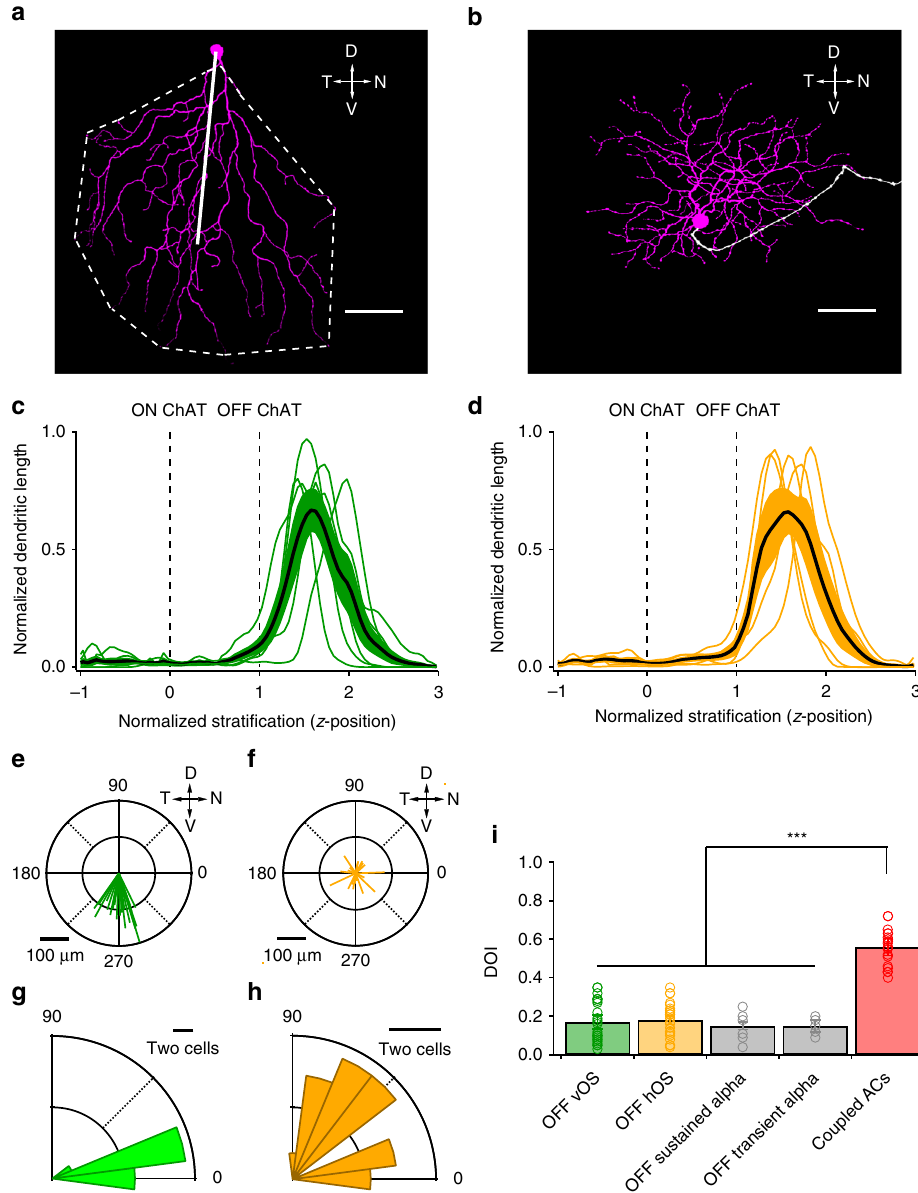
Fig. 2 Morphology of OFF OS RGCs. a , b Dendritic morphologies of vertical OFF OS RGC ( a ) and horizontal OFF OS RGC ( b ). OFF dendrites are represented in magenta and axons are in white. Scale bar = 50 μ m. Dashed line in a shows outline of dendrites. Solid line is the vector from the soma to the center of mass (COM). c , d Z -pro fi les of OFF vOS ( c ) and OFF hOS ( d ) dendritic arbour strati fi cation. Thin green and orange lines indicate pro fi les of individual OFF vOS and OFF hOS cells, respectively. Thick black lines represent mean for OFF vOS ( n = 6) and OFF hOS ( n = 5). Dotted lines indicate ON and OFF starburst planes. The inner nuclear layer (INL) is located to the right and the ganglion cell layer (GCL) is located to the left. Shaded regions indicate SEM across cells. e , f Polar plots of COM vectors of OFF vOS ( n = 24) ( e ) and OFF hOS ( n = 22) ( f ) RGCs. Scale bar = 50 μ m. g , h Rose plots of absolute differences between OS angle ( θ OS ) and COM vector angle ( θ COM vector ) of ON vOS RGCs ( n = 24) ( g ), and OFF hOS RGCs ( n = 22) ( h ). i Dendritic orientation index (DOI) of OFF OS RGCs ( n = 26 OFF vOS and 23 OFF hOS), OFF sustained alpha ( n = 6), OFF transient alpha ( n = 5) and amacrine cells coupled to OFF OS RGCs ( n = 19). *** p <